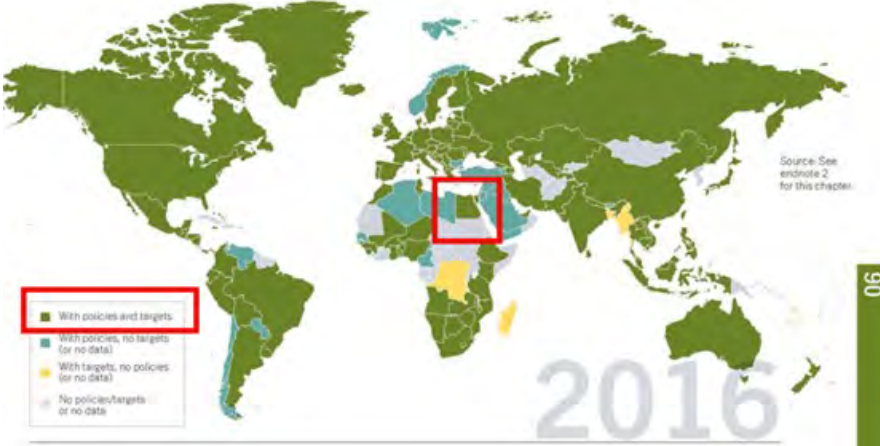
Figure 11. (GRS Full report